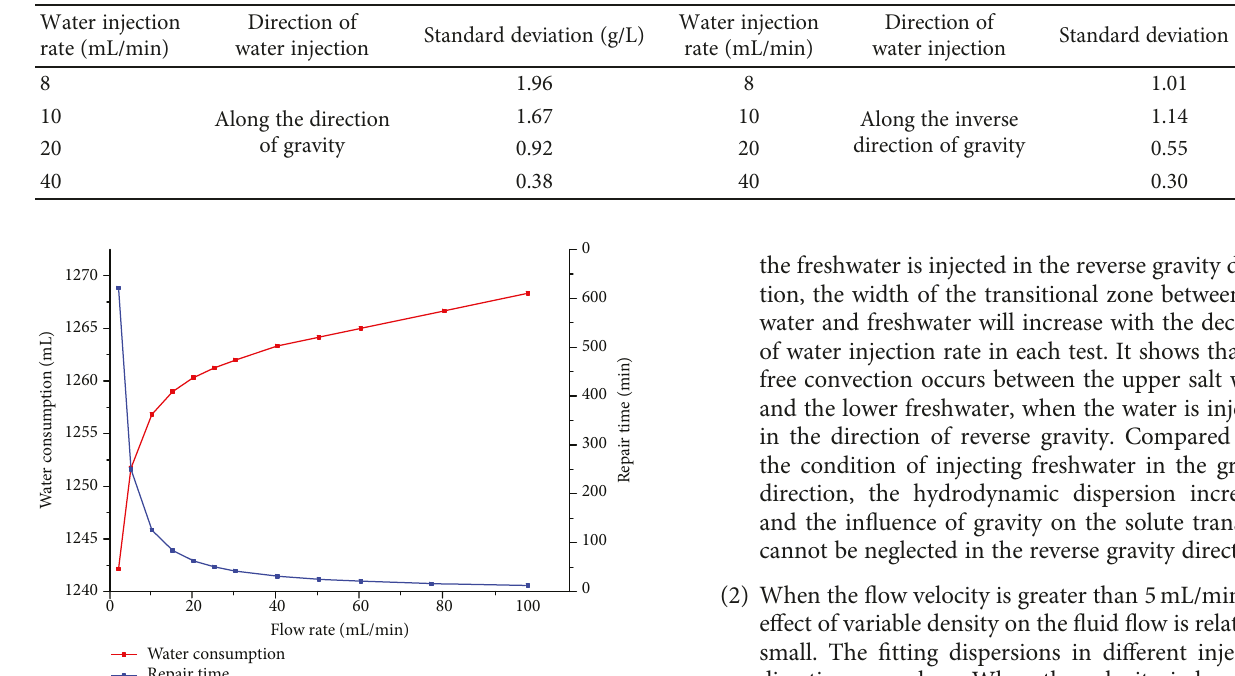
Table 6: Error analysis of standard parameters.